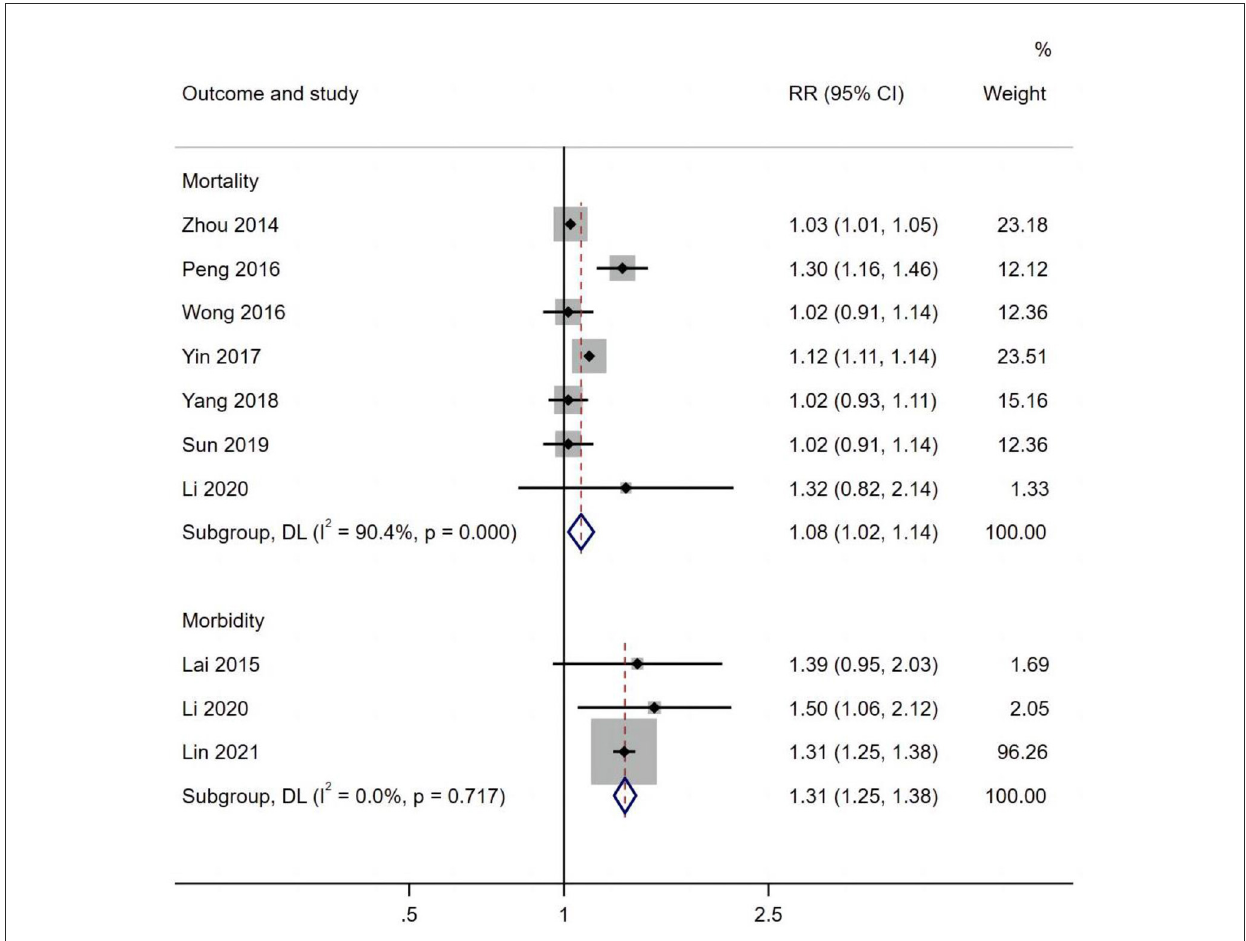
FIGURE3 PM 2.5 effects on respiratory mortality and